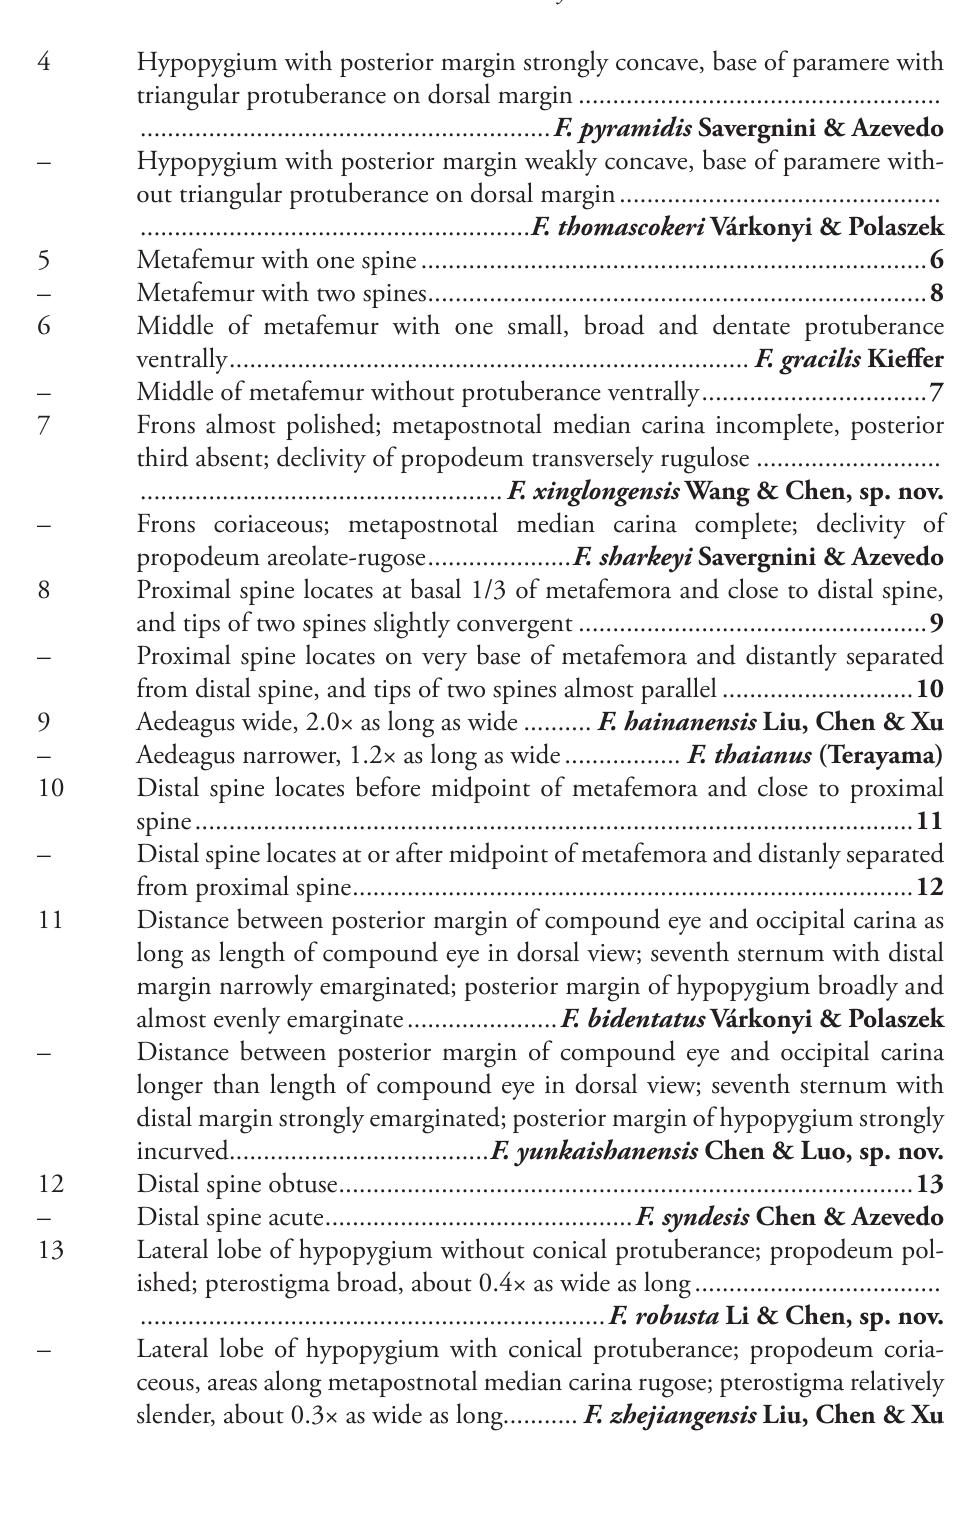
Distal spine locates at or after midpoint of metafemora and distanly separated Distance between posterior margin of compound eye and occipital carina as long as length of compound eye in dorsal view; seventh sternum with distal margin narrowly emarginated; posterior margin of hypopygium broadly and Distance between posterior margin of compound eye and occipital